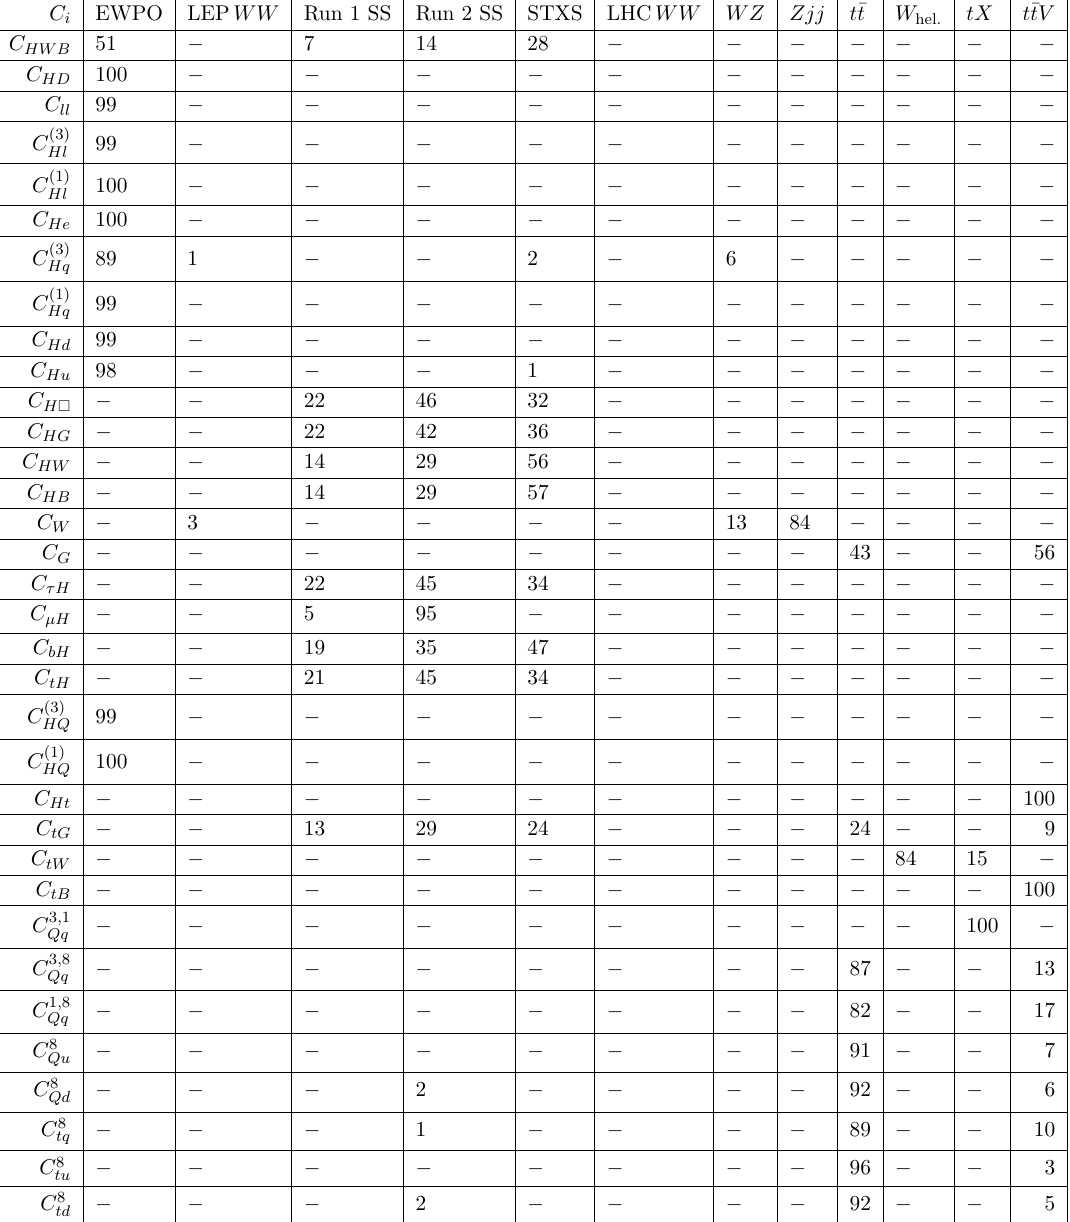
Table 7 . Relative constraining power in percent of different datasets on each coefficient of the global fit individually. Entries below 1% are not displayed. ‘SS’, W strength, W -helicity fraction and single top data,